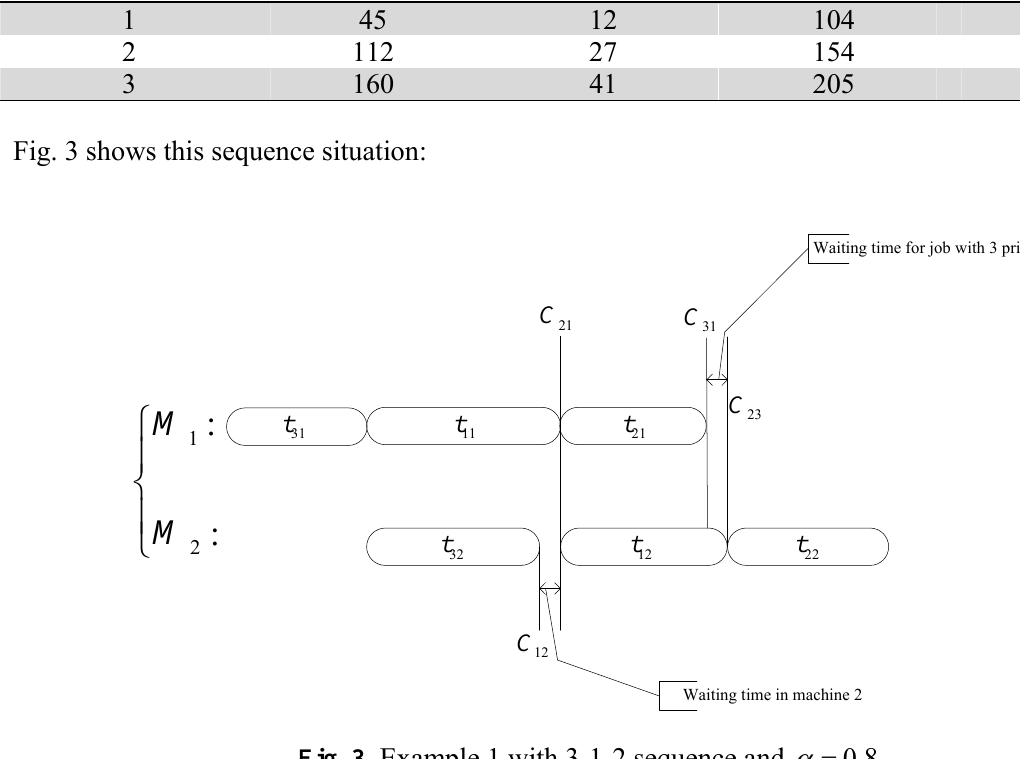
Fig. 3. Example 1 with 3-1-2 sequence and 0.8